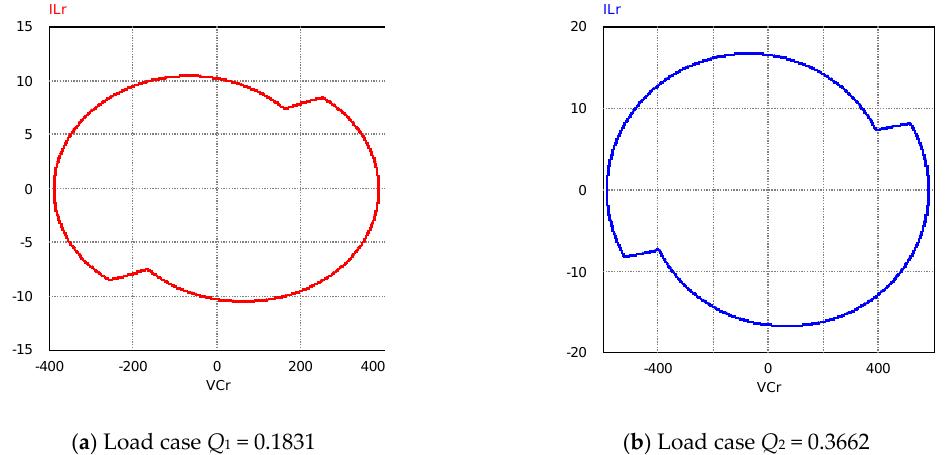
Figure 16. PSIM simulation results of the state-trajectories below resonant frequency.